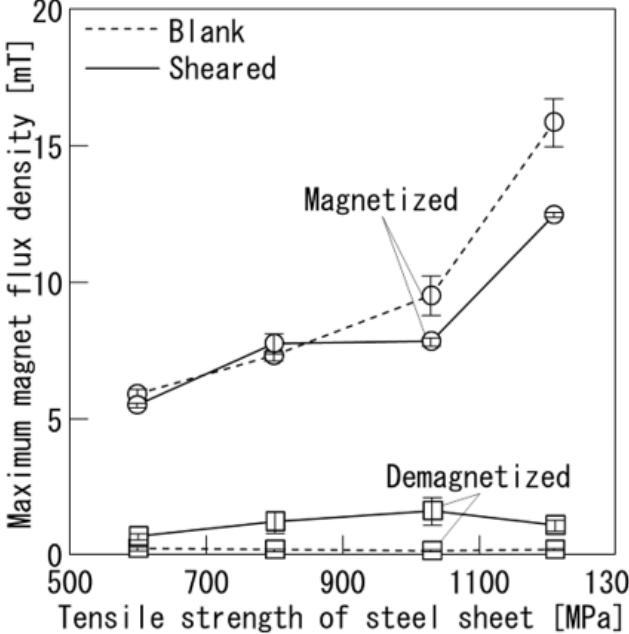
Figure 8. Effect of tensile strength on the maximum flux density.